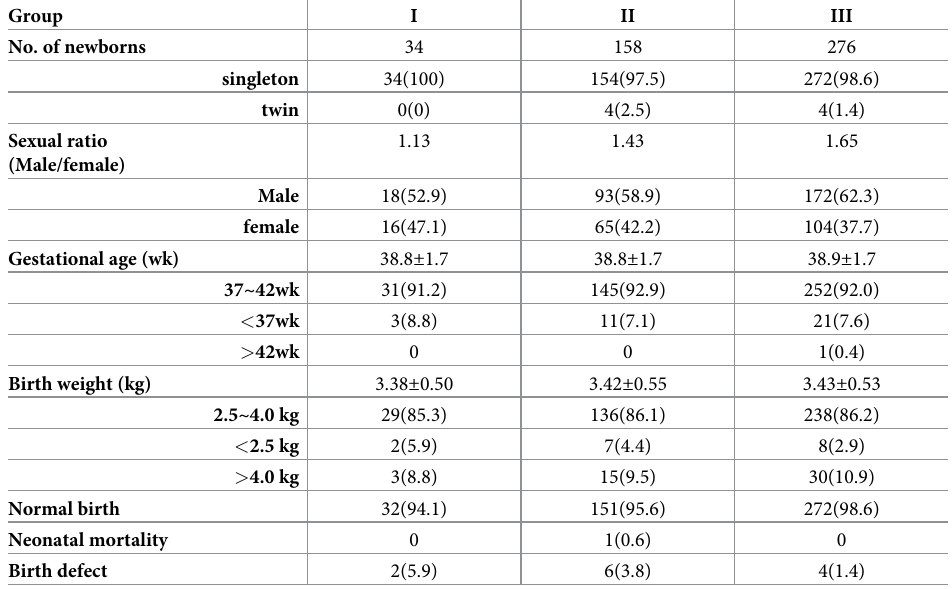
Table 5. Neonatal outcomes of PGD/PGS patients transferred a single blastocyst with different hatching types.